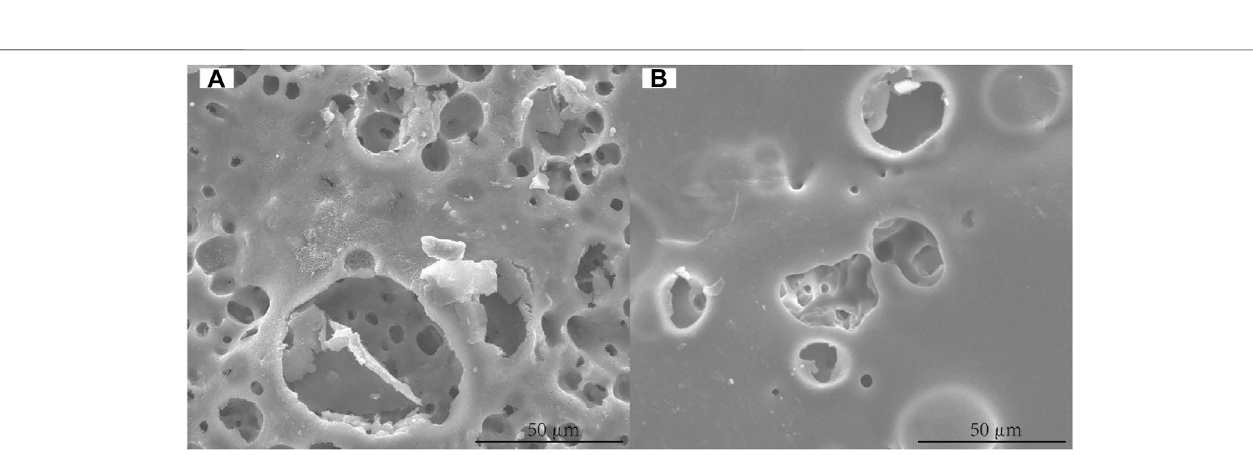
Frontiers in Physics |